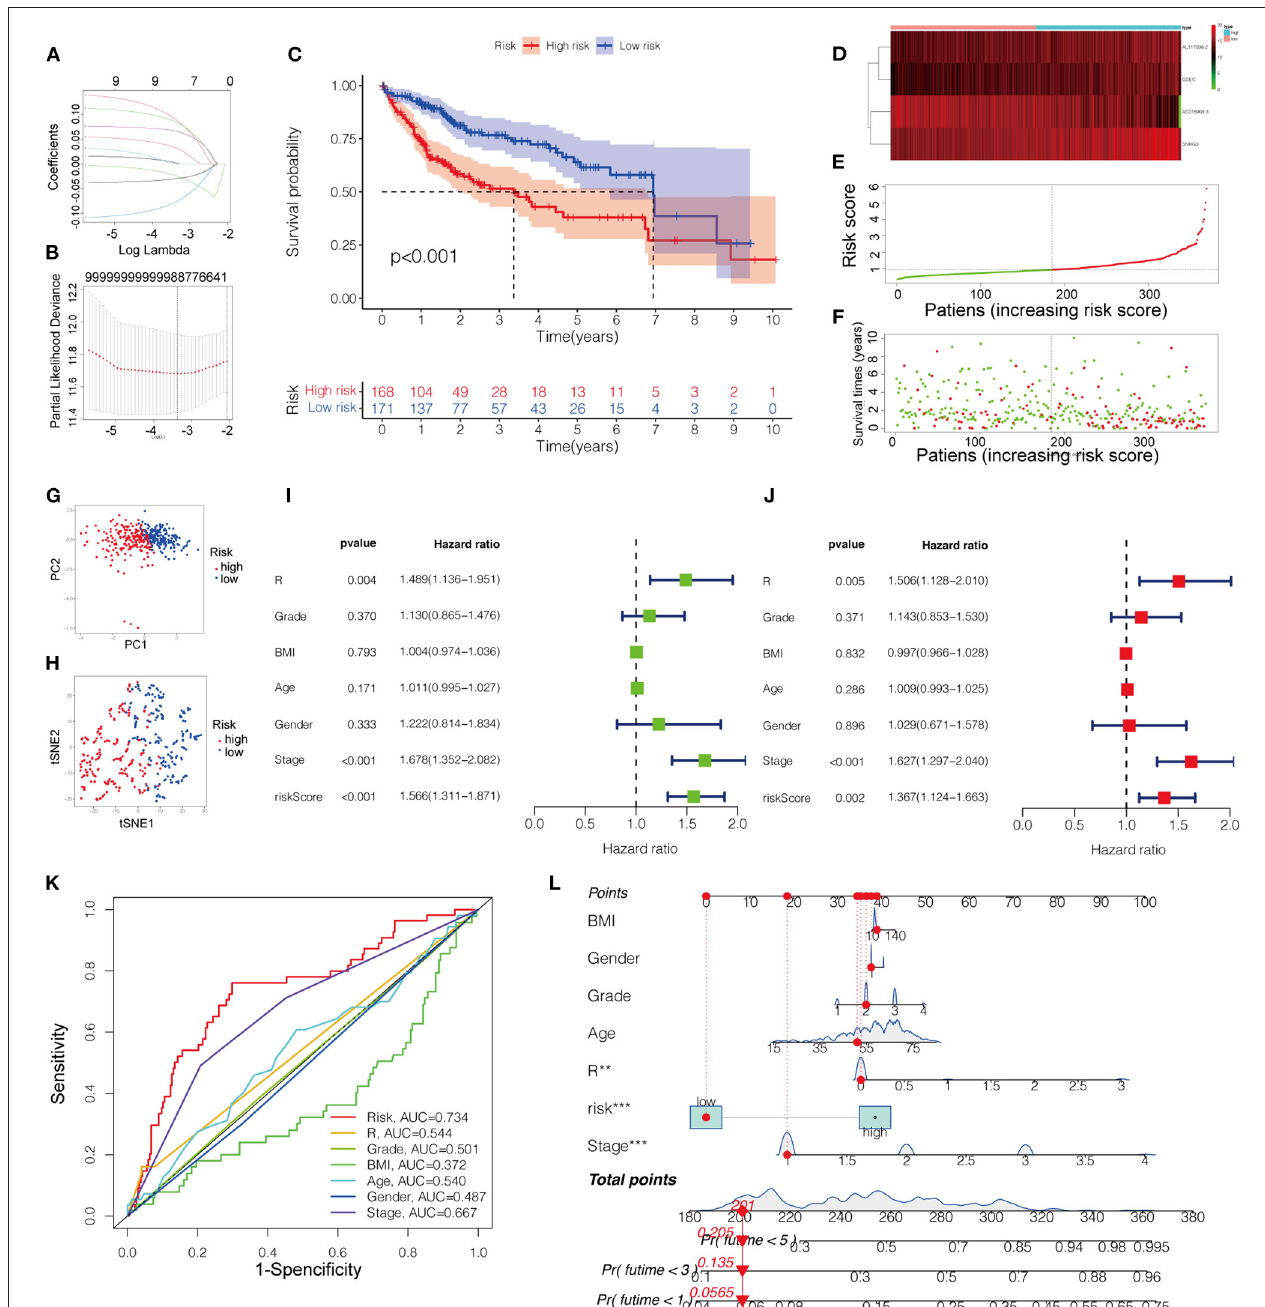
FIGURE 4 | (A) LASSO regression of the 9 OS-related genes. (B) Cross-validation for tuning the parameter selection in the LASSO regression. (C) Kaplan-Meier survival curves for OS of patients in low- and high-risk groups. (D) Heatmap for the expression profiles of pyroptosis-related lncRNAs in the low- and high-risk groups. (E) The risk curve according to the risk score of each LIHC patient. (F) The scatterplot based on the survival status of each patient. (G) PCA plot for LICH patient. (H) Dot plot for low- and high-risk clusters identified by t-SNE algorithm. (I,J) The univariate and multivariate Cox regression analysis of risk score of the prognostic model and clinical features regarding prognostic value. (K) The receiver operating characteristic curves (ROC curves) of risk score and clinicopathological characteristics. (L) Nomogram for both clinicopathological factors and prognostic pyroptosis-related lncRNAs. OS, overall survival.